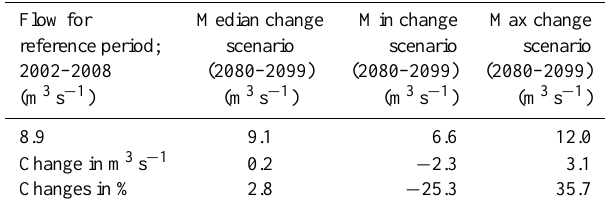
Table 10. Changes in average stream flow for the years 2080–2099 with respect to minimum, median and maximum changes to tem- perature and precipitation in East Africa projected by models used in scenario A1B (IPCC, 2007).